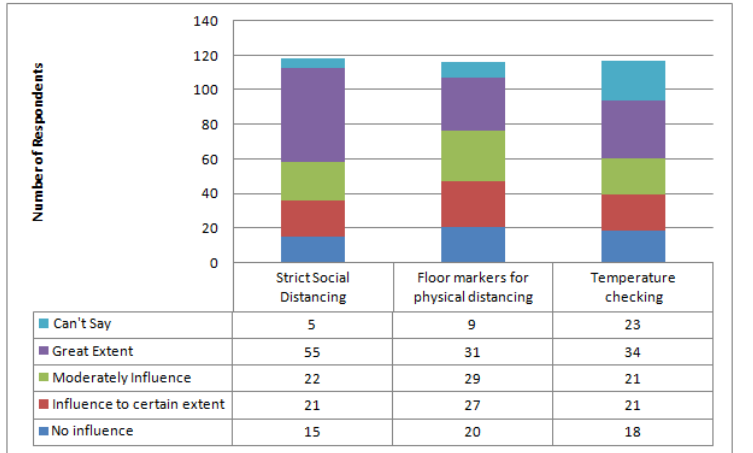
Graph 8: Factors That Increases the Confidence of People to Fight against the Pandemic (Source: Authors‟